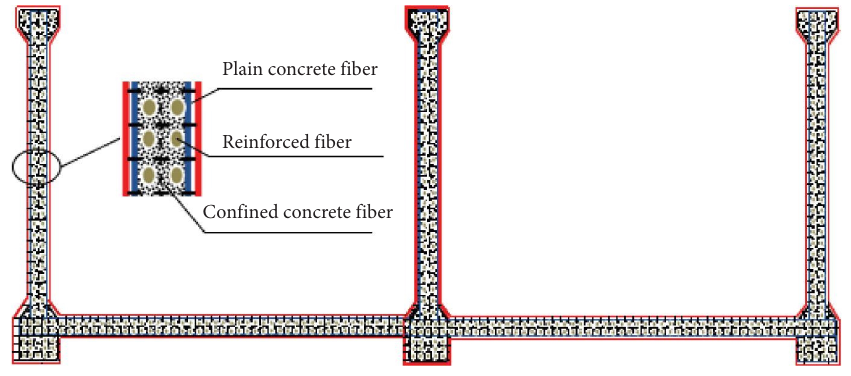
Figure 9: Fiber beam element model of double aqueduct. Table 1: Te frst 10 modes and frequencies of the aqueduct structure